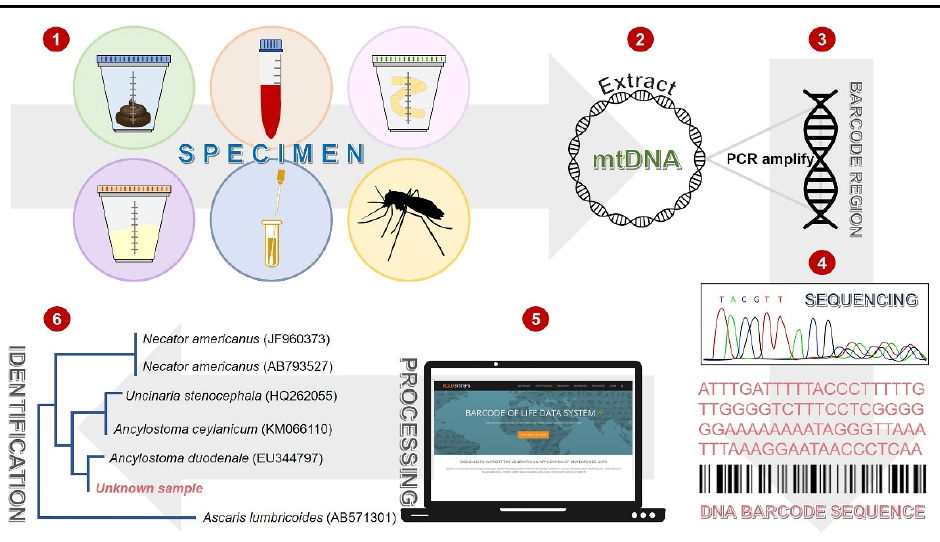
Figure 2. Steps of DNA barcoding technique for medical parasite and arthropod diagnoses. DNA is extracted from a clinical specimen ( 1 ), and a barcode region is amplified using the universal primers ( 2 , 3 ). The PCR product is purified and submitted for nucleotide sequencing ( 4 ). This sequence is subsequently analyzed for species identification based on the nucleotide sequence similarity to the referenced sequences in the BOLD database ( 5 , 6 ). Table 2. Recent advanced tools for diagnosis of medical parasites and arthropods.